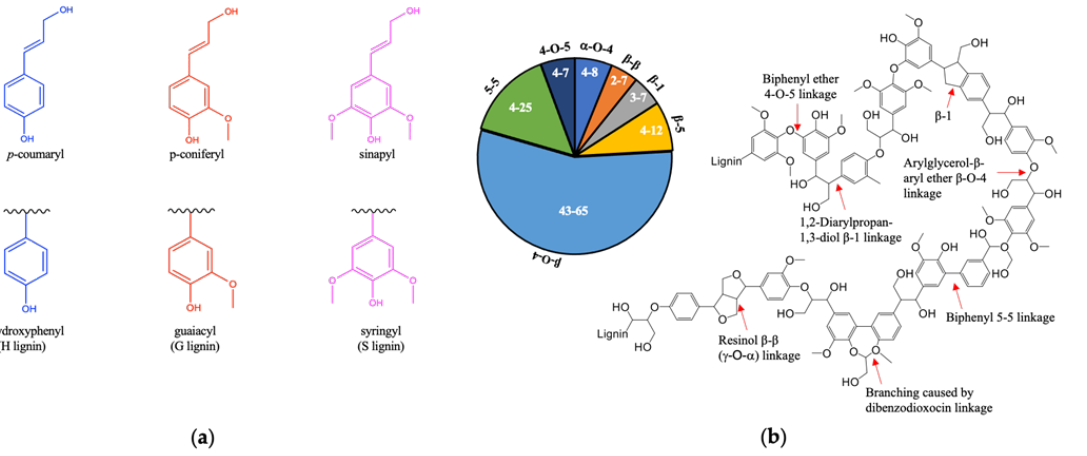
Figure 1. Relative structures of three monomeric subunits in lignin ( a ). Linkage amount and its position in lignin structure (number/100 phenylpropane units) ( b ). These are modified versions from previous reports